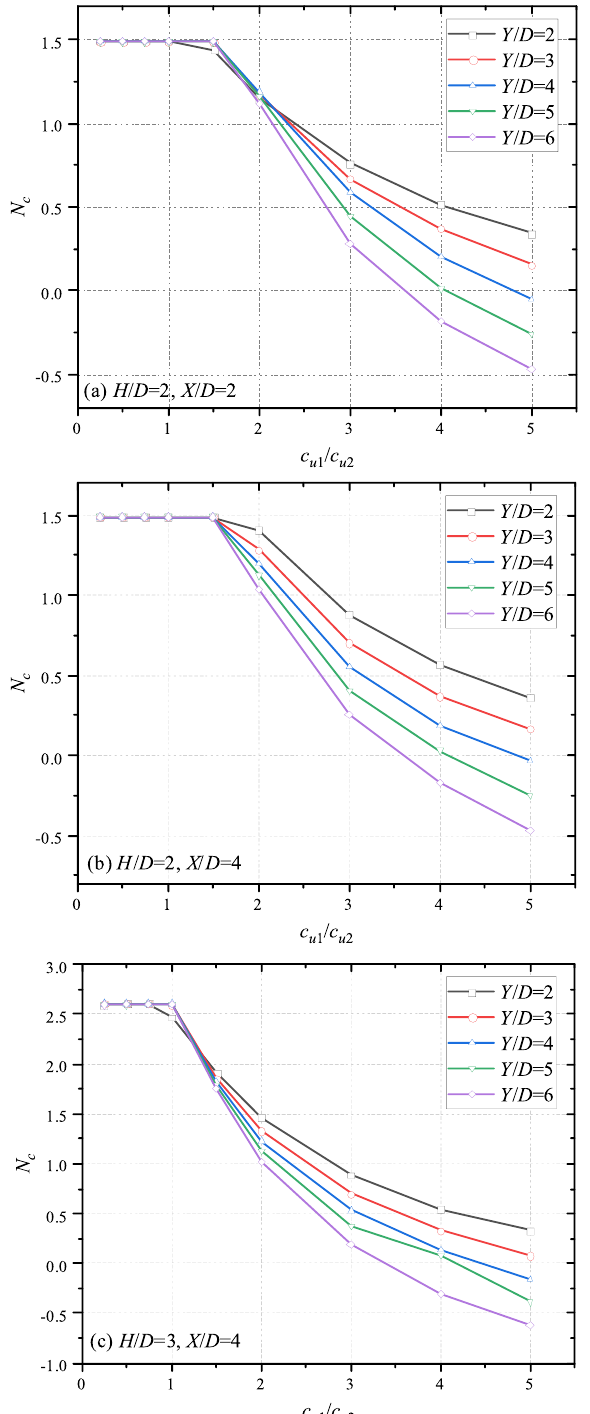
Figure 5. Variation of N c with different c u1 / c u2 and Y / D for ( a ) H / D = 2, X / D = 2; ( b ) H / D = 2, X / D = 4 and ( c ) H / D = 3, X / D =